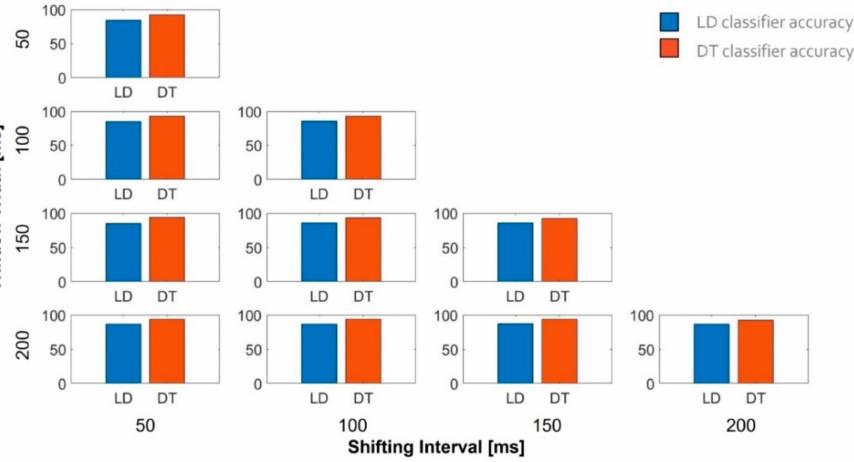
Figure 11. Accuracy of the two classifiers estimated for different combinations of window width and shifting